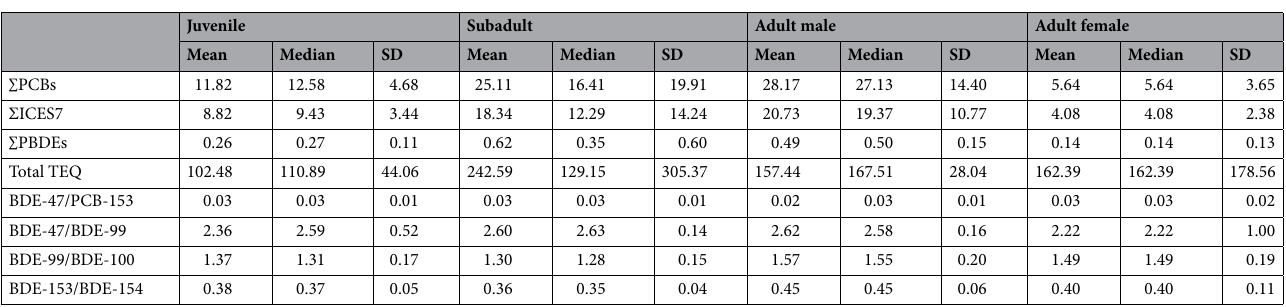
Table 1. Mean, median, standard deviation of ΣPCB, ΣICES7, and ∑PBDE, in the blubber of Cuvier’s beaked whale of juvenile (n = 4), subadult male (n = 8), adult male (n = 6) concentrations are expressed in mg/kg lipid weight. Total TEQ is expressed in pg/g lipid weight. Mean, median and standard deviation, of BDE-47/PCB- 153, BDE-47/BDE-99, BDE-99/BDE-100, BDE-153/BDE-154